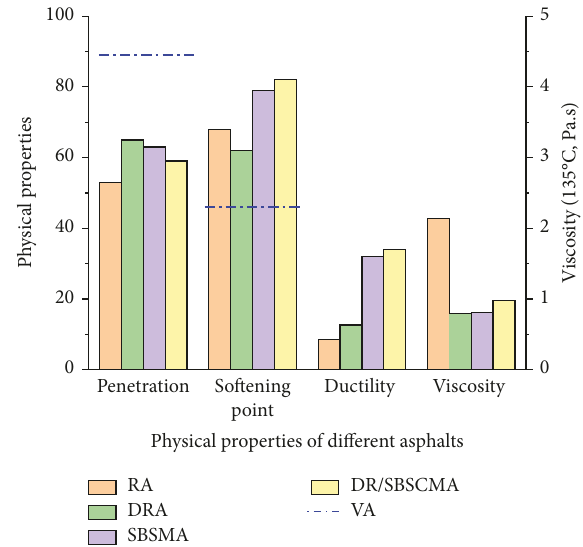
Figure 5: Test results of different basic performance indexes of